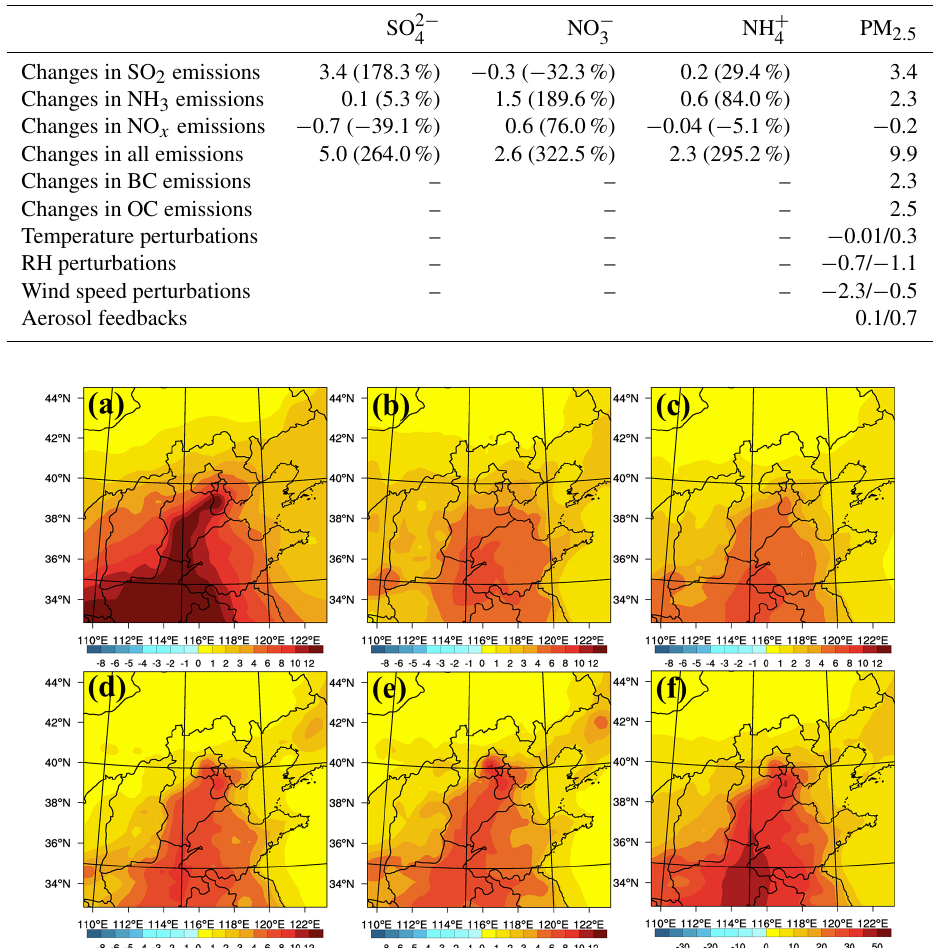
Table 3. Monthly domain mean changes of sulfate, nitrate, ammonium, and PM 2 . 5 concentrations (µgm − 3 ) due to emission and meteorology perturbations, and aerosol feedbacks (the two values of PM 2 . 5 changes are for meteorology perturbations and aerosol feedbacks based on 1960 and 2010 emission levels, respectively).